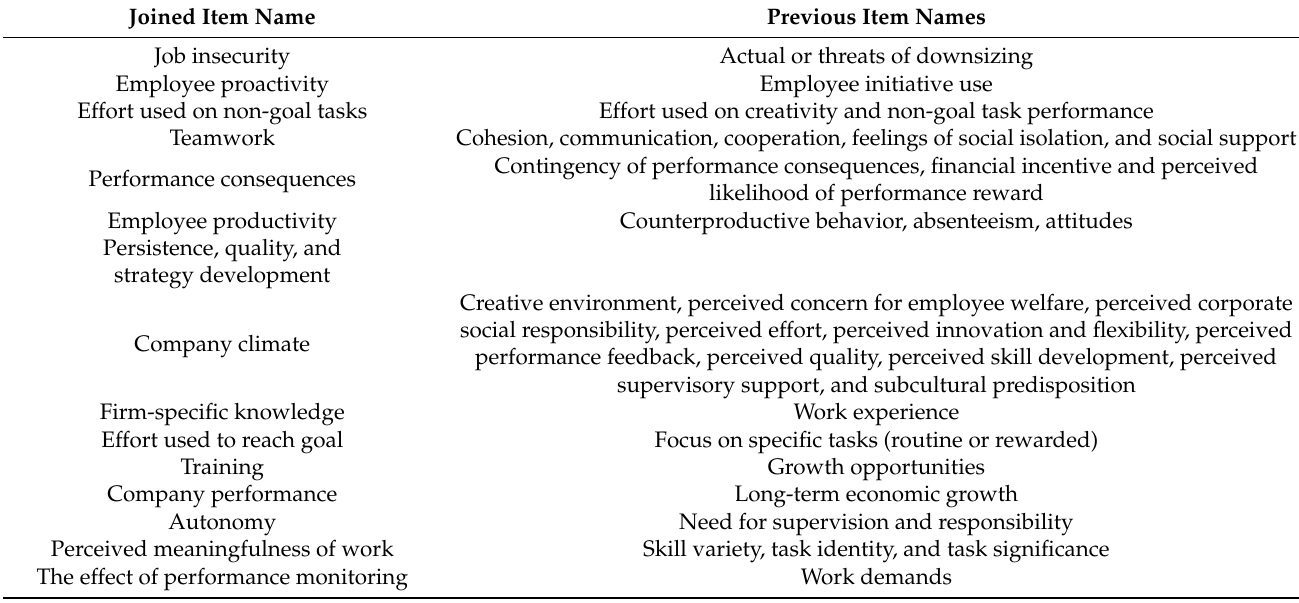
Table 4. Items in on the synthesized CLD that have incorporated other